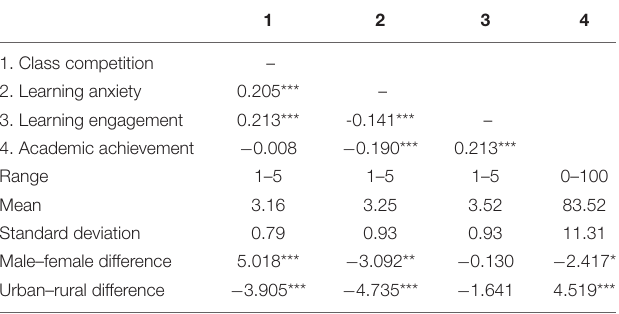
TABLE 1 | Descriptive statistics and correlation analysis for each variable.